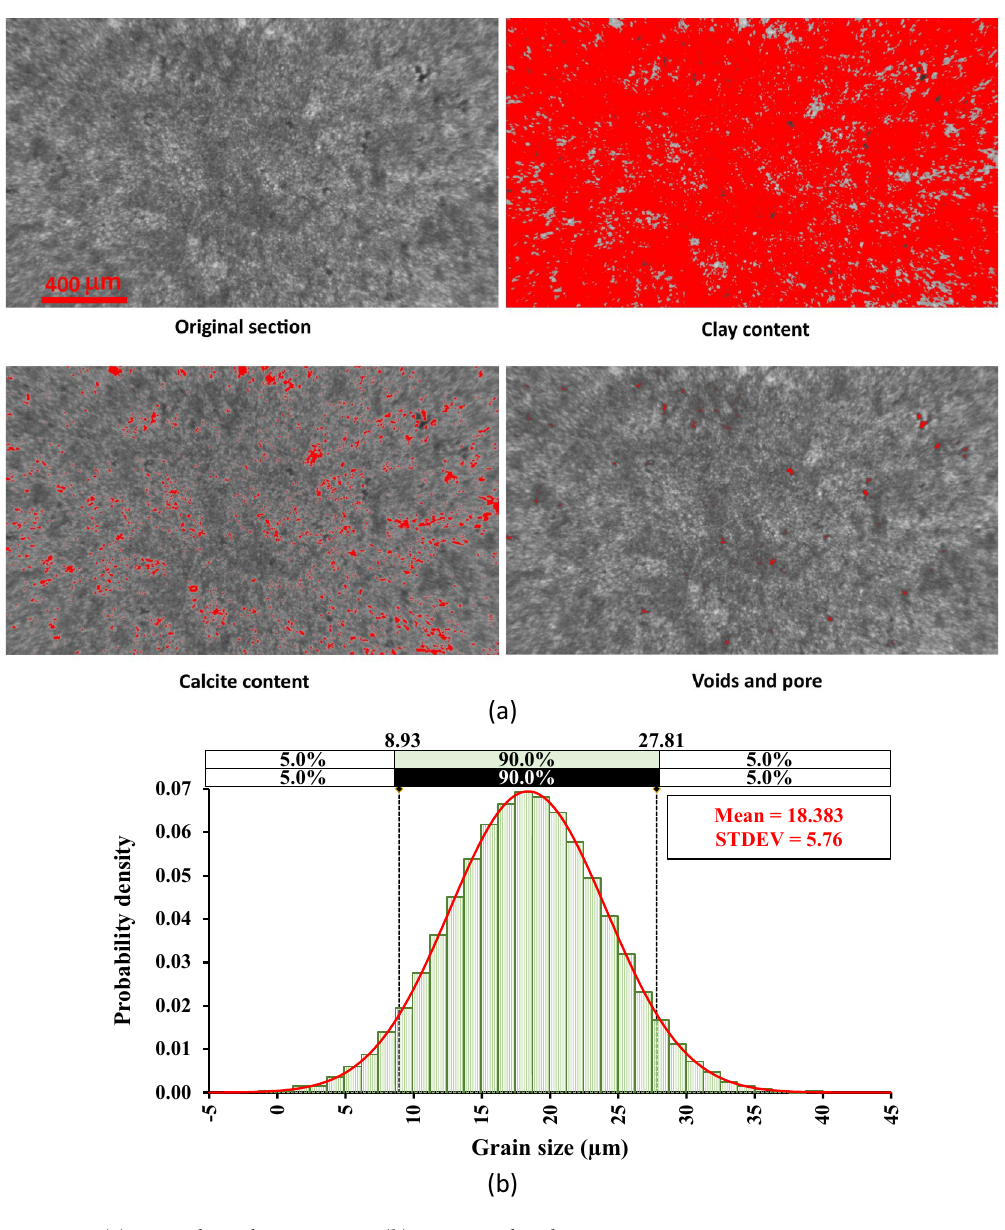
Figure 4. ( a ) Mineralogical composition, ( b ) grain size distribution.